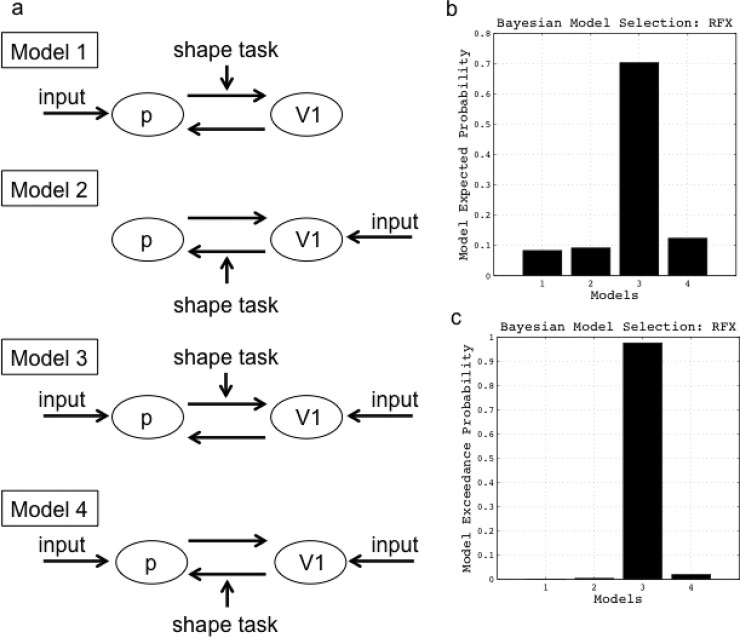
Shape task vs. word task (cluster threshold of p < 0.05 [corrected] with a voxel threshold of p < 0.001 [uncorrected]).Th = thalamus, IFG = inferior frontal gyrus, MFG = medial frontal gyrus.